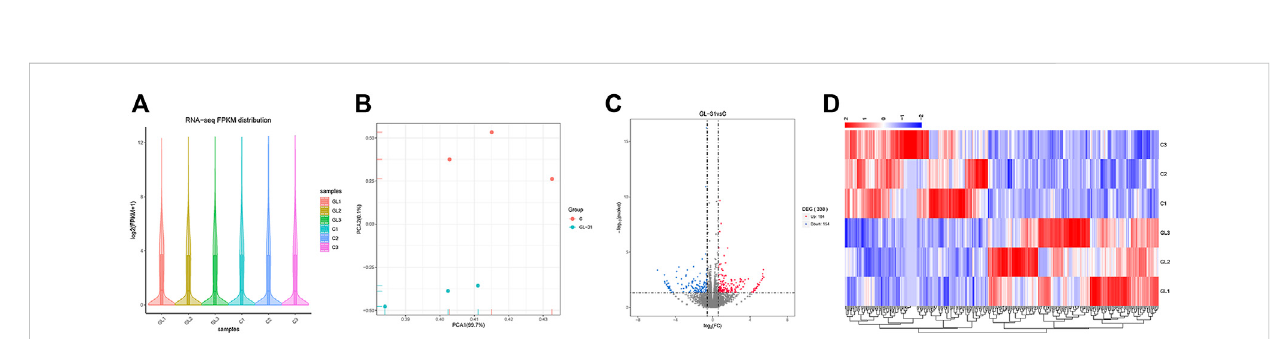
FIGURE 5 RNA-seqdataanalysis. (A) Distribution ofgeneexpressionlevelsofeachsample(GL1,GL2,GL3andC1,C2,C3); (B) PCAwasperformedonsamples; (C) The volcano map mapped 338 differential genes, including 154 downregulated and 184 upregulated genes; (D) Heat map of differentially expressed gene clustering. Heat map colour represents the level of gene expression; red indicates high expression, and blue indicates low expression.